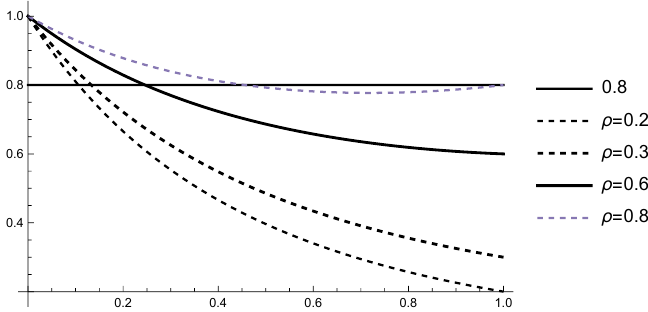
Figure 1. Graph of ρ α Γ ( 1 + α ) for various ρ and the lower bound 0.8.